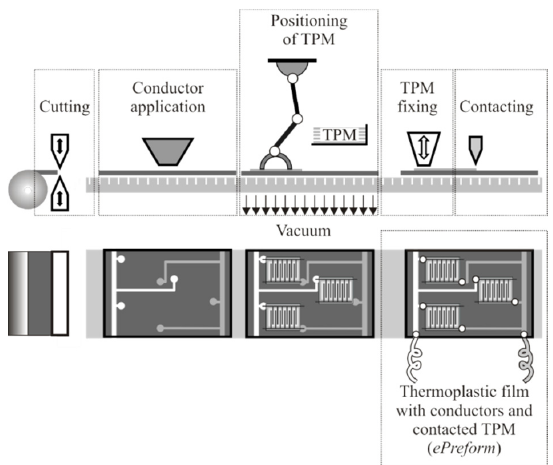
Figure 9. Schematic of the ePreforming process.